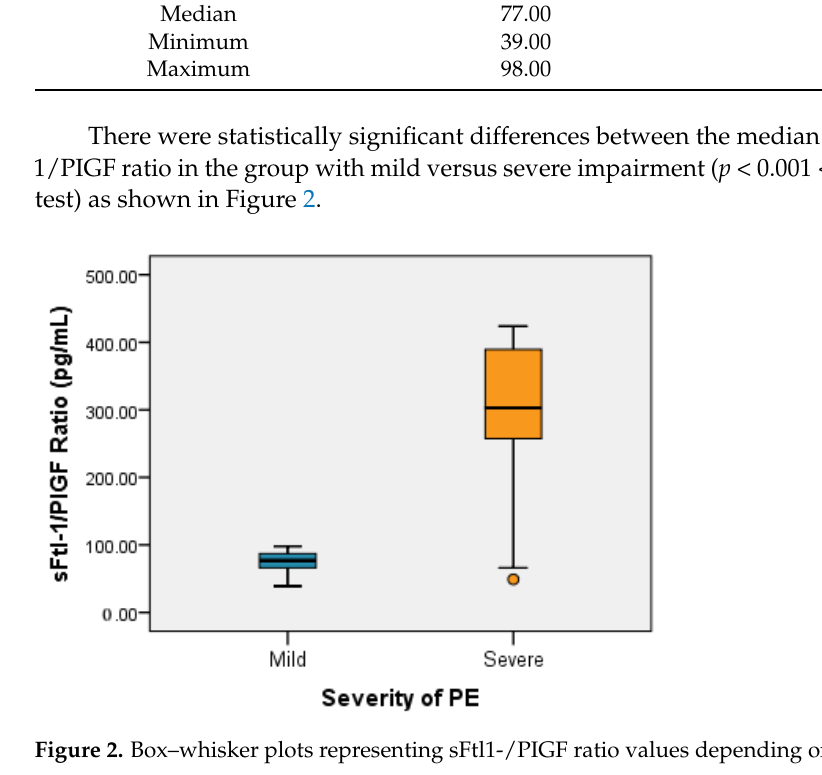
Table 6. Values of the sFtl-1/PIGF ratio (pg/mL) depending on the severity of PE. Degree of PE Severity Mild PE Severe PE No. 23 36 Median 77.00 303.00 39.00 98.00 424.00